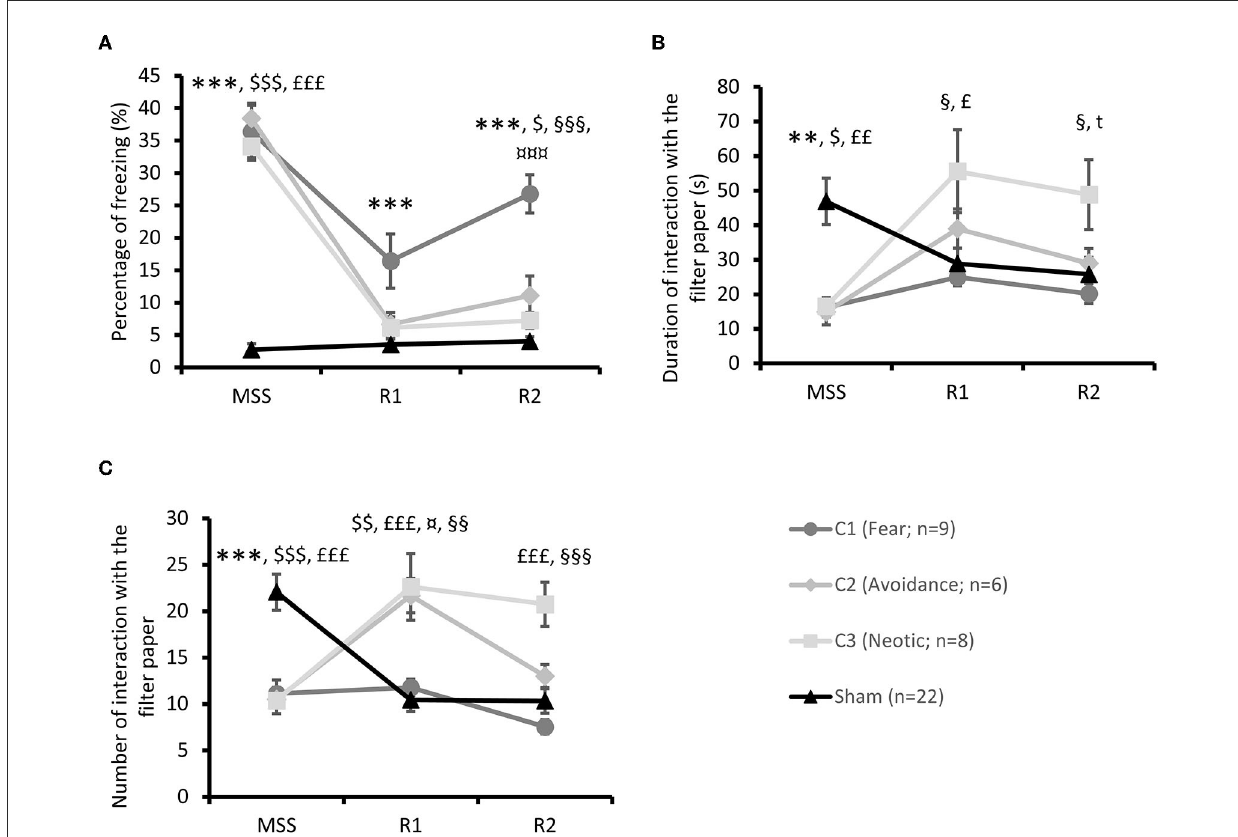
FIGURE5 Stress group clustering. (A) Percentage of freezing during MSS, and R1 and R2 re-exposures. Post-hoc tests *** p < 0.001 between the C1 subgroup (Fear) and the Sham group, $ p < 0.05 between the C2 subgroup and the Sham group, $$$ p < 0.001 between the C2 subgroup (Avoidance) and the Sham group, £££ p < 0.001 between the C3 subgroup (Neotic) and Sham group, §§§ p < 0.001 between the C1 and C3 subgroups, ¤¤¤ p < 0.001 between the C1 and C2 subgroups. (B) Duration in seconds of interaction with TO during MSS, and R1 and R2 re-exposures. Post-hoc tests ** p < 0.01 between the C1 subgroup and the Sham group, $ p < 0.05 between the C2 subgroup (Avoidance) and Sham group, £ p < 0.05 between the C3 subgroup (Neotic) and Sham group, ££ p < 0.01 between the C3 subgroup (Neotic) and Sham group, § p < 0.05 between the C1 and C3 subgroups, t p < 0.10 between the C3 subgroup and the Sham group. (C) Number of interactions with TO during MSS, and R1 and R2 re-exposures. Post-hoc tests *** p < 0.001 between the C1 subgroup and the Sham group, $$ p < 0.01 between the C2 subgroup and the Sham group, $$$ p < 0.001 between the C2 subgroup and the Sham group, £££ p < 0.001 between the C3 subgroup and the Sham group, ¤ p < 0.05 between the C1 and C2 subgroups, §§ p < 0.01 between the C1 and C3 subgroups, §§§ p < 0.001 between the C1 and C3 subgroups. Results are expressed as mean ± SEM.